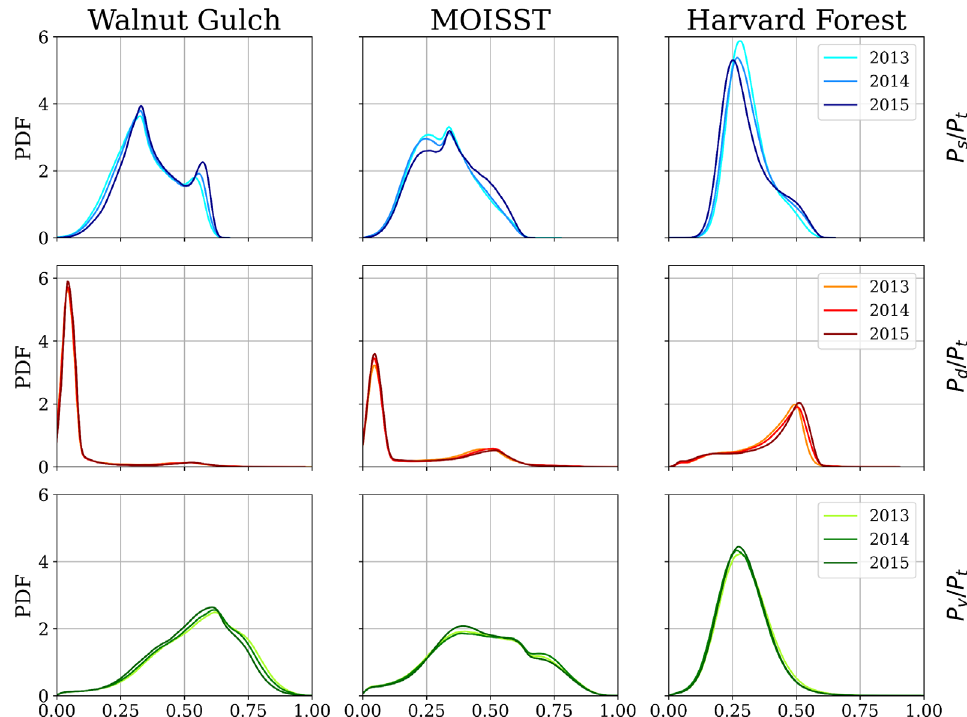
Figure 6. Probability density functions (PDFs) of estimated normalized, relative power indices representing soil ( P s / P t ; first row), dihedral ( P d / P t ; second row), or volume ( P v / P t , third row) scattering at the AirMOSS monitoring sites. The average values of all four dates per year are shown (Figure 1, Section 2). Left column: Walnut Gulch, AZ, USA. Middle column: MOISST, OK, USA. Right column: Harvard Forest, MA, USA.